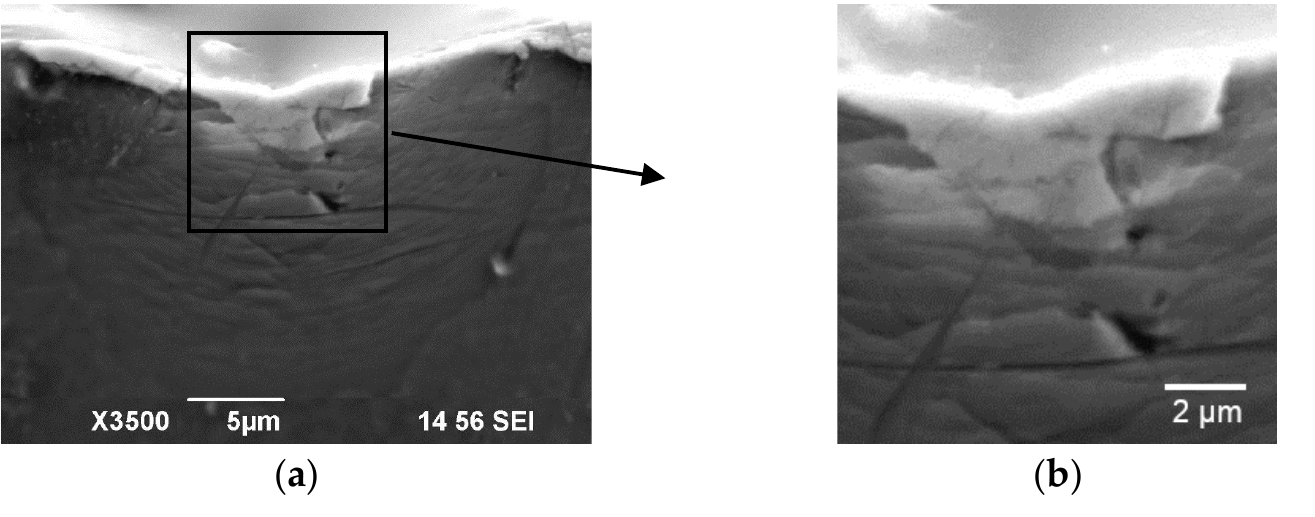
Figure 6. Bonded indentation of BMG Vit105 after relaxed annealing: ( a ) deformation area on the side surface area near the indent (SEM); ( b ) same, enlarged.